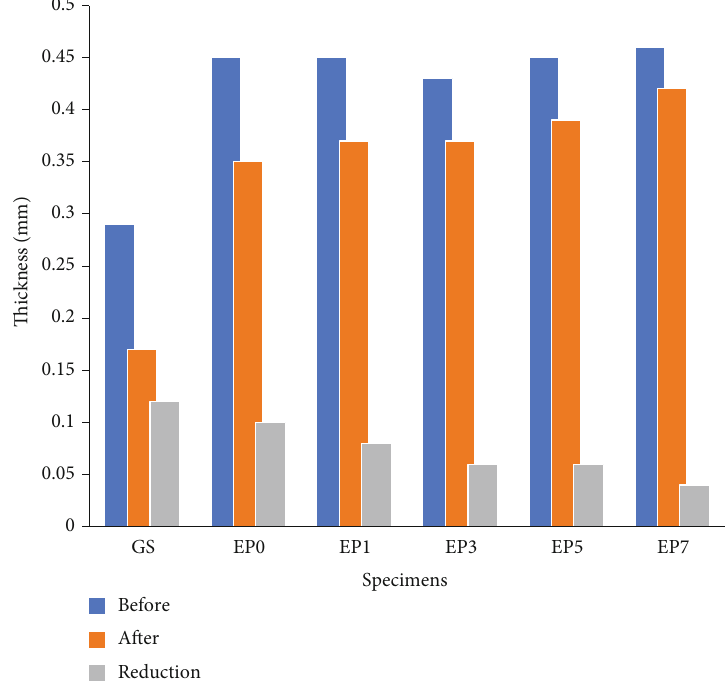
Figure 10: The reduction in thickness before and after immersions, in 2 wt.% of H